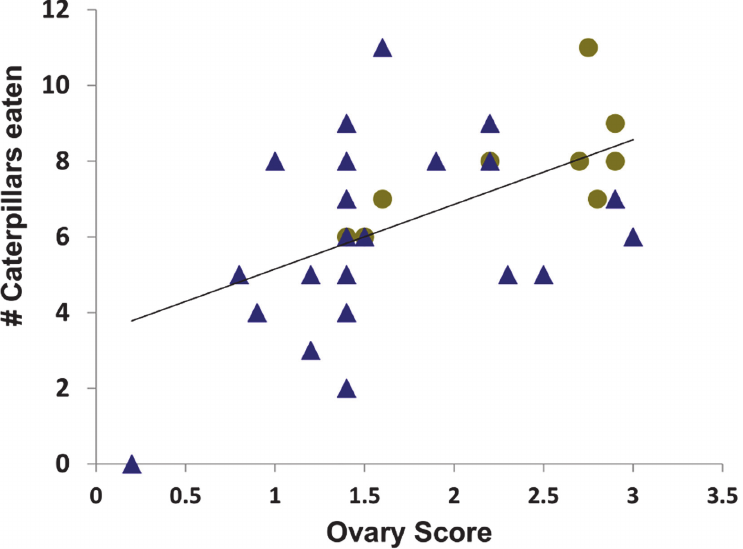
Fig 3. Plot of the ovary score vs. number of caterpillars eaten within the two weeks after eclosion for individual wasps reared on the restricted (gold circles, N = 9), and unrestricted (blue triangles, N = 23) diets. The trend line includes all of the data.